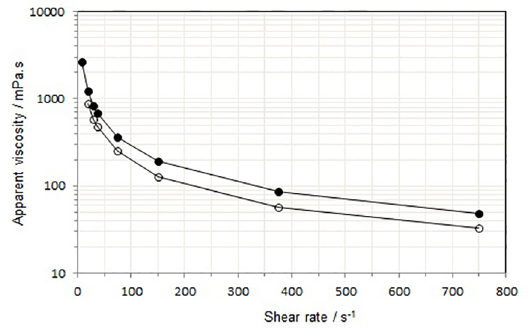
Figure 3. Apparent viscosity (in log scale) as a function of shear rate to an alumina-suspension (closed circles) and HA-suspension (open circles) with 0.016 wt% of HA.